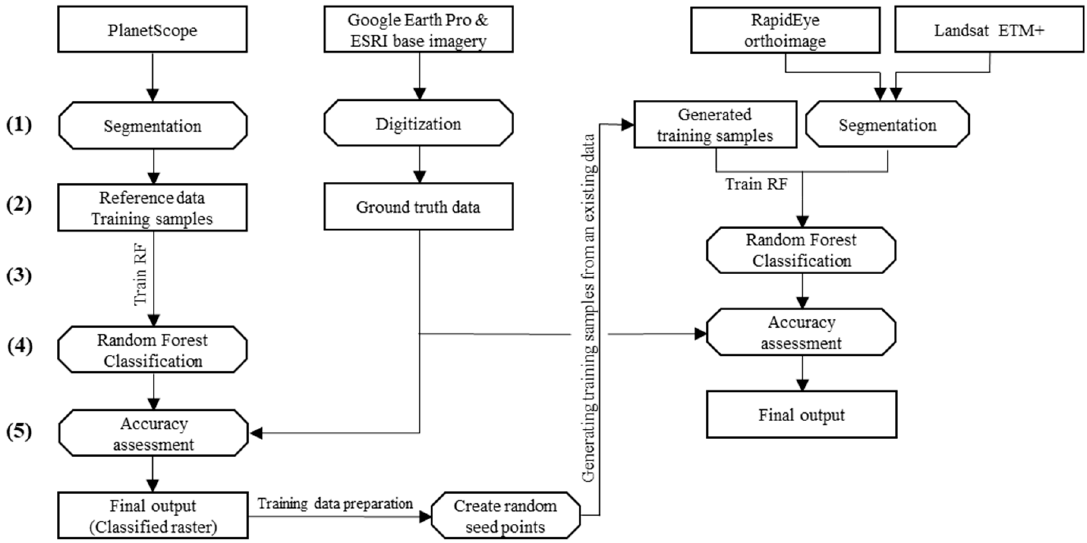
Figure 2. Workflow of supervised image classification.